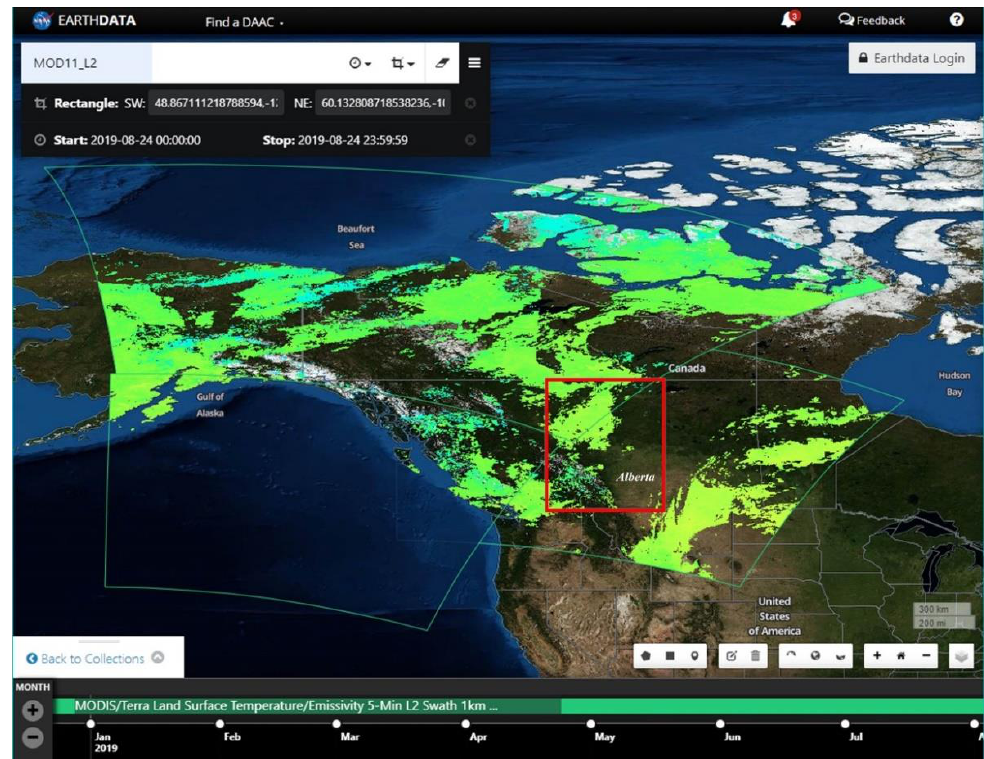
Figure 1. Terra MODIS acquired Land Surface Temperature/Emissivity 5-Min L2 1 km Swath Data showing overlap of three data files of Ts (bounded by green thin curved outlines of the rectangles). The overlapping swath data covering a larger geographic extent for a given AOI of Alberta, Canada (rectangle in red bold outline) that were acquired on 24 August 2019 (source: NASA EARTHDATA). The yellowish green and green to cyan colours in each swath frame were the available land surface temperature (Ts) data, and cloud-contaminated or bad-quality pixels were declared here as ‘no data’.